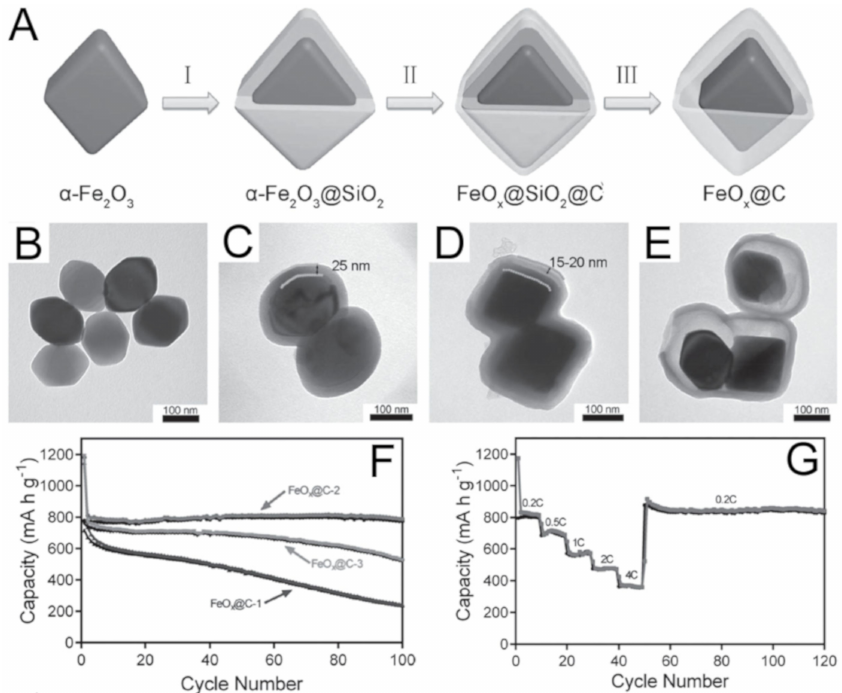
Figure 11. ( A ) Schematic illustration showing the formation of FeO x @C yolk–shell